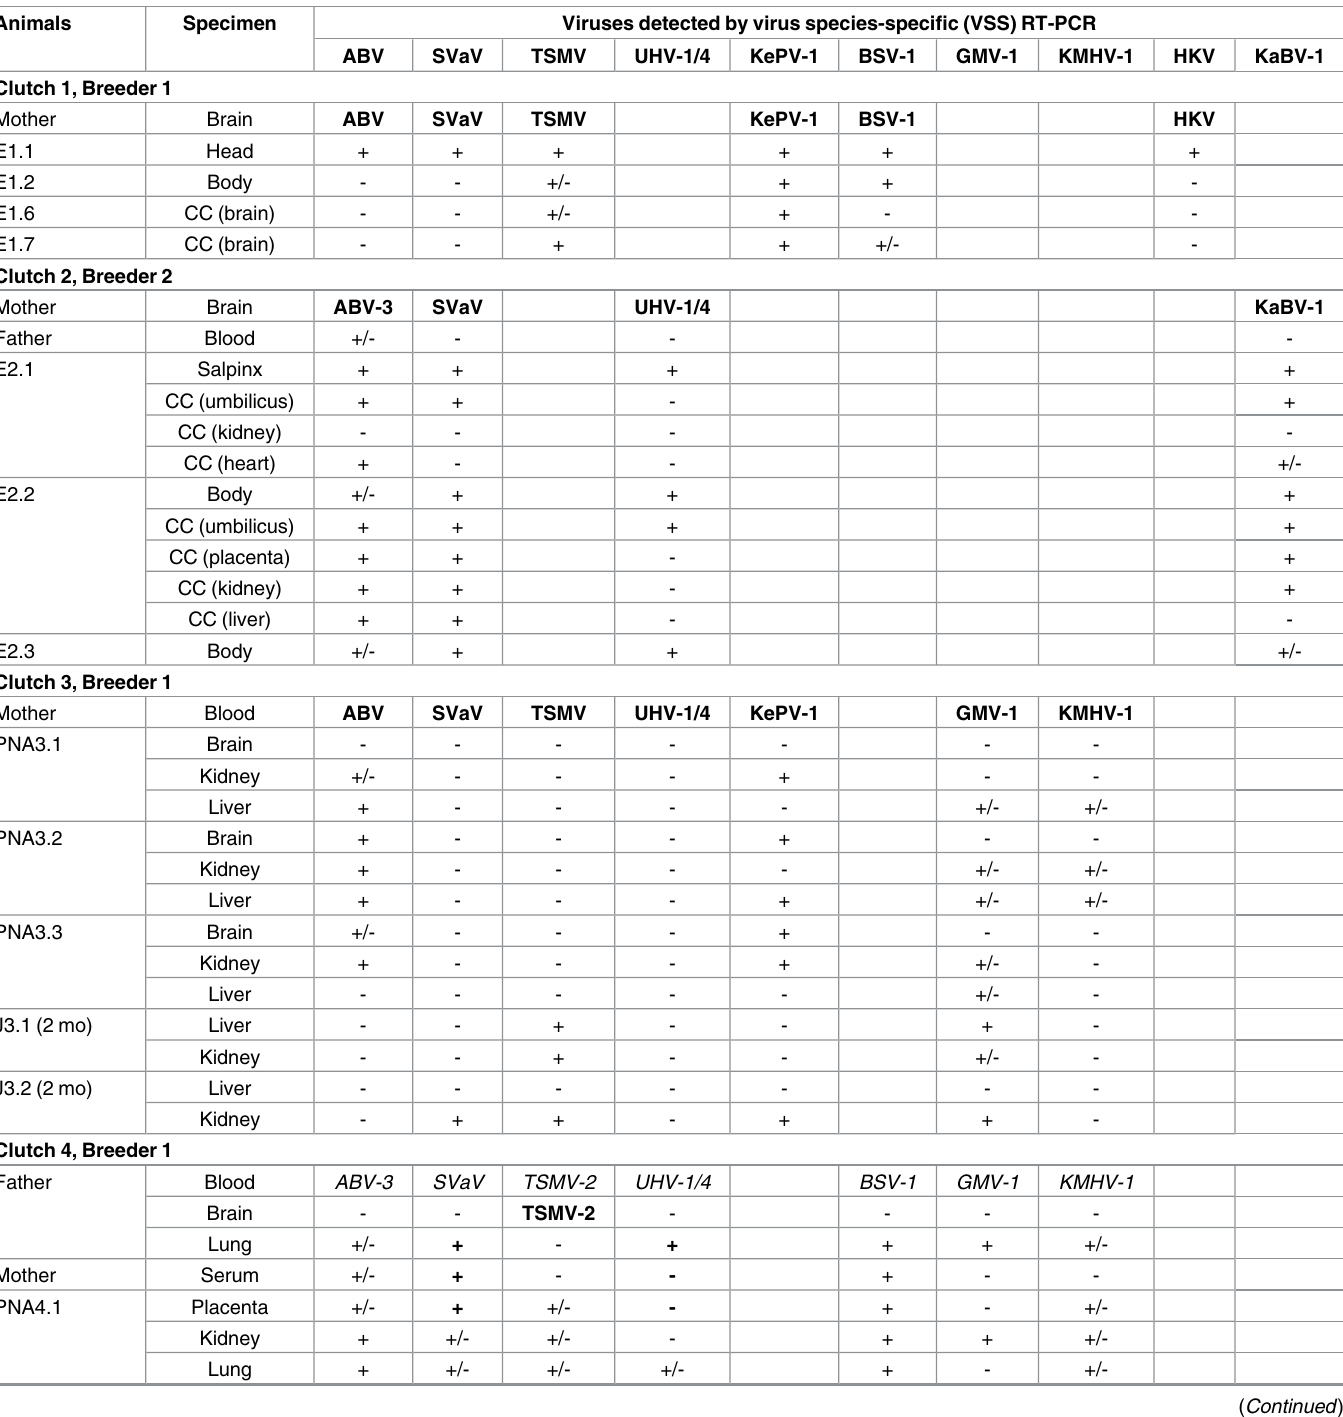
Table 2. Detailed results obtained from the different specimens used for the RT-PCR approach to identify L segments (abbreviations and acces- sion codes are given in S1 Table, and in materials and methods) in each animal in clutches 1–5. The virus genomes de novo assembledfrom NGS data of the parentalsample and confirmedby VSS RT-PCR indicatedby virus abbreviationsin bold, and viruses detected by VSS RT-PCR are shown in italics in parents and with + sign in the offspring. +/- sign indicatesan ambiguous RT-PCR